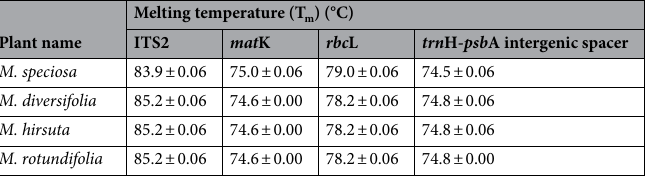
Table 3. The melting temperature values (T m ) of four barcode regions derived from Mitragyna species. SD-standard